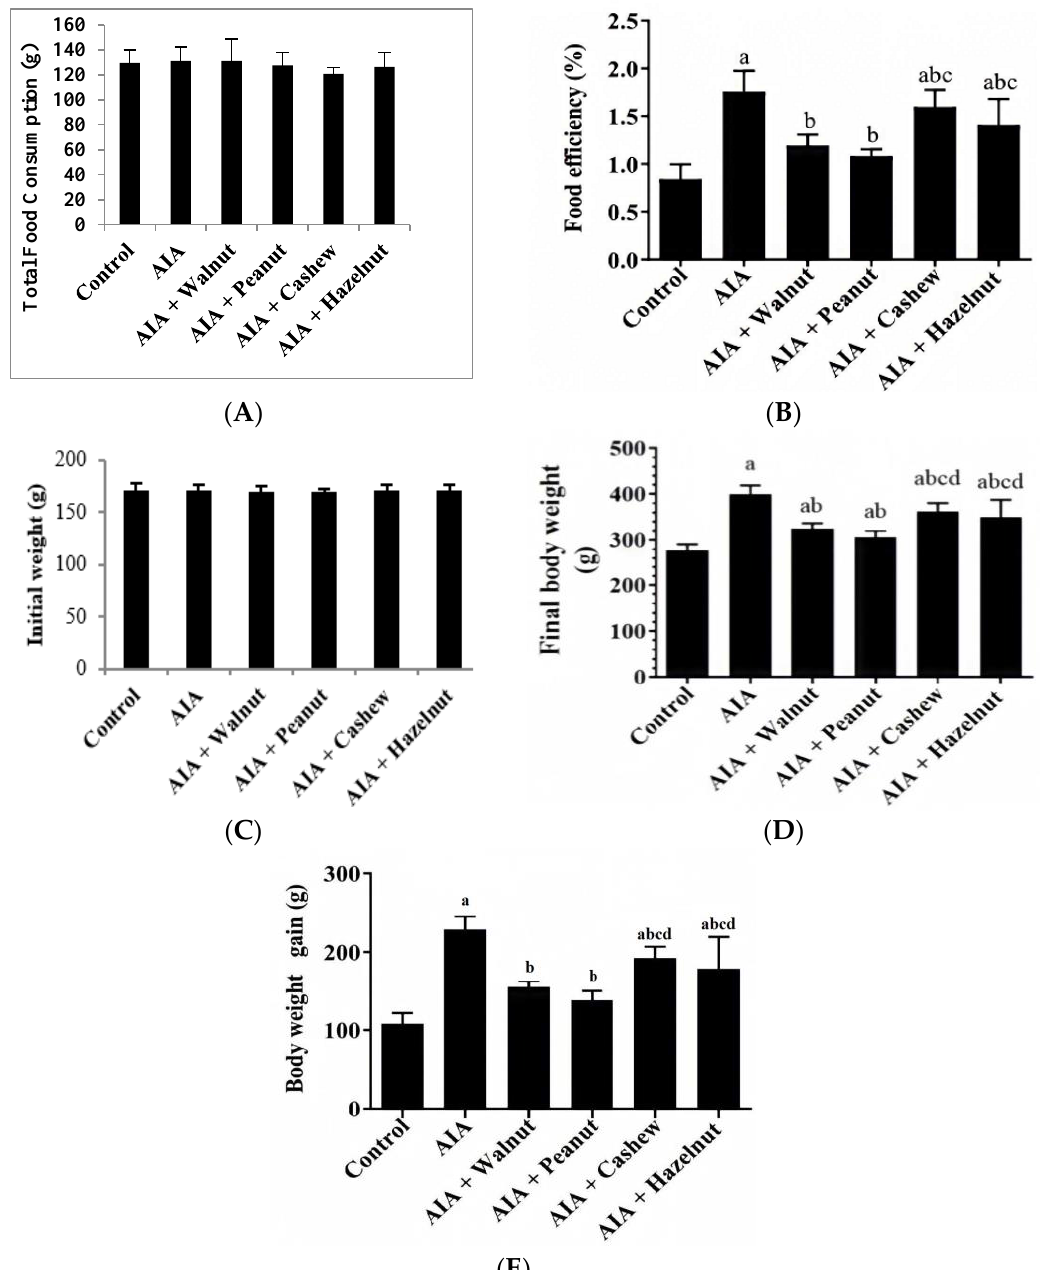
Figure 2. Changes in total food consumption ( A ), food efficiency ( B ), initial body weight ( C ), final body weight ( D ), and weight gain ( E ) in all groups of rats. Model: One-way analysis of variance (ANOVA) with a statistical significance assumed at p ≤ 0.05 followed by Tukey's HSD post hoc test for statistically significant p -value. Data are presented as mean ± SD for n = 5 rats/groups. a: Significantly different from the control rats. b: Significantly different from the adjuvant-induced arthritis model rats (AIA). c: Significantly different from AIA + walnut oil. d: Significantly different from AIA + peanut oil.